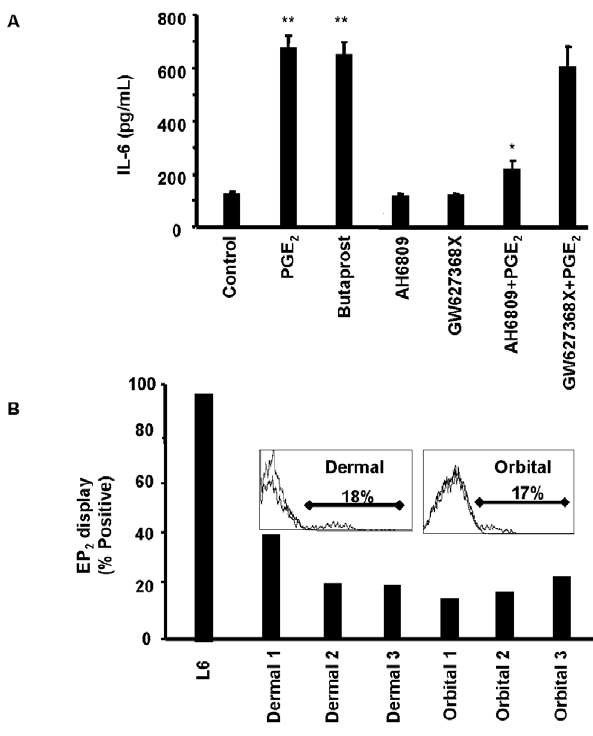
Figure 6. EP 2 mediates the actions of PGE 2 on IL-6 expression in orbital fibroblasts. A : Confluent cultures were treated with nothing, Butaprost (10 m M) or PGE 2 (1 m M) in presence or absence of EP 2 inhibitor AH6809 (10 m M), EP 4 inhibitor GW627368X (10 m M) for 16 h. Media were subjected to IL-6 ELISA. Data are expressed as mean 6 SD of three independent determinations. * denotes P , 0.005 compared to PGE 2 alone, ** denotes P , 0.005 compared to no treatment. B : Comparison of surface EP 2 receptor display by orbital and dermal fibroblasts as determined by flow cytometry. L6 cells serve as the positive control. Inset histograms represent the levels of shift when compared with